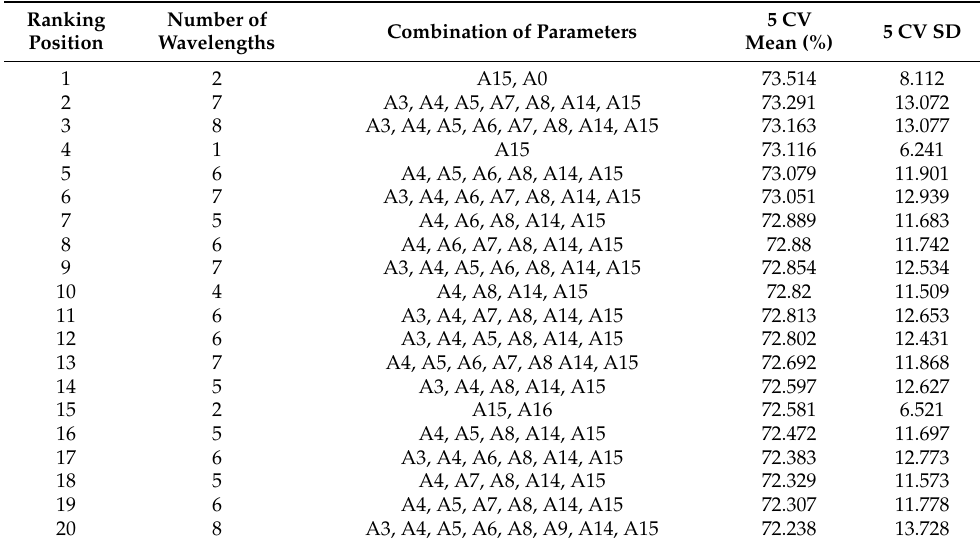
Table 4. Top 20 ranking for multiple wavelength usage for brown eggshells without hyperparameter optimization.